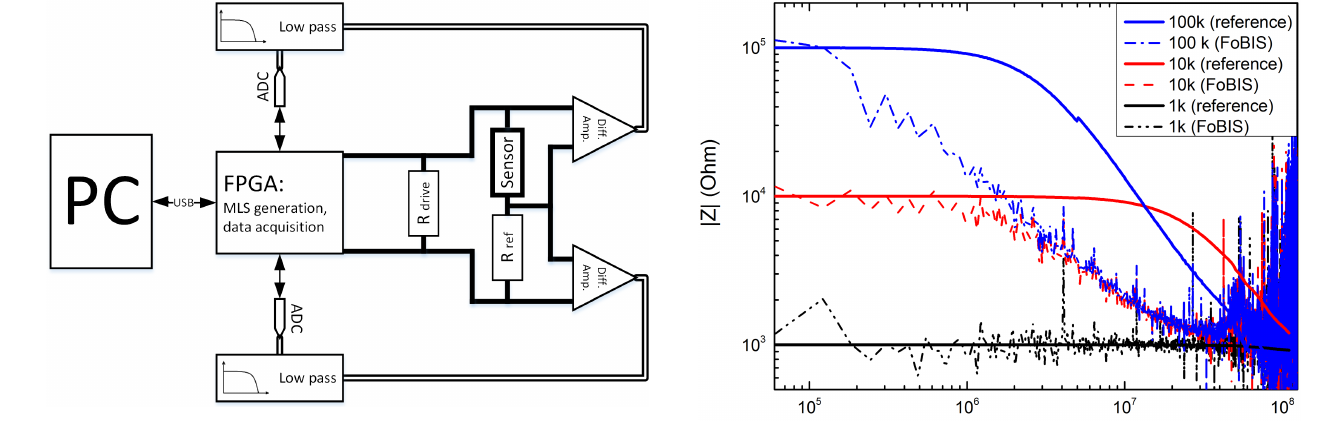
Figure 2. Hardware setup of the FoBIS measurement system (cf. Schüler et al., 2014).